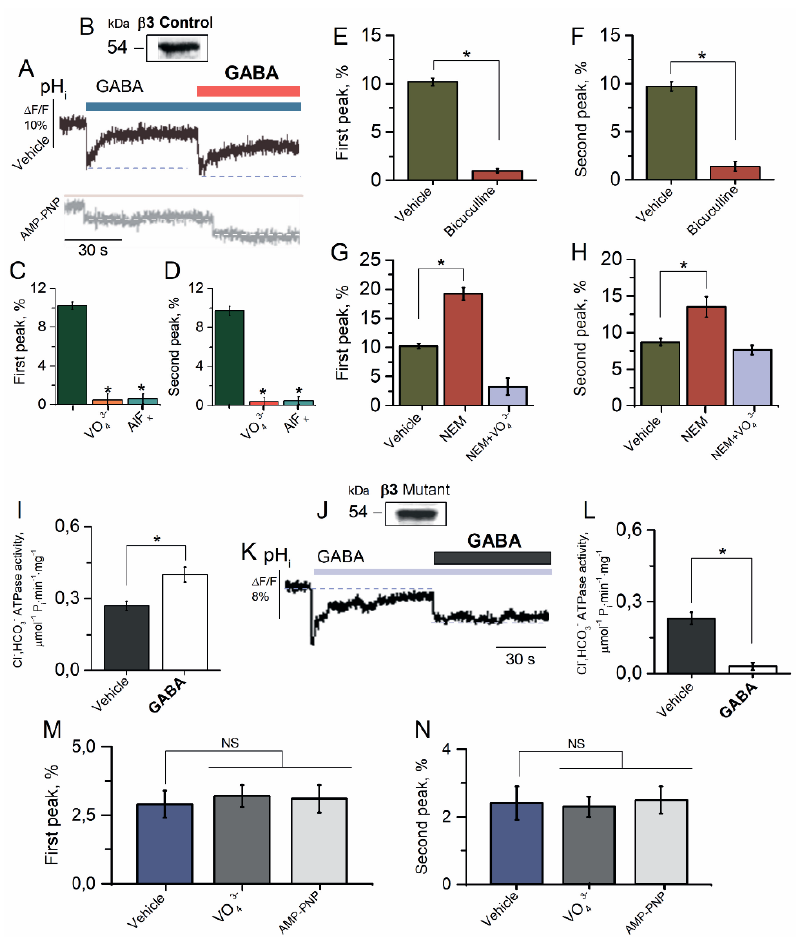
Figure 4. β 3 subunit is responsible for GABA A R resensitization in HEK 293FT cells. ( A ) Representa- tive images of BCECF fluorescence changes in HEK 293FT cells expressing β 3 GABA A R isoform and